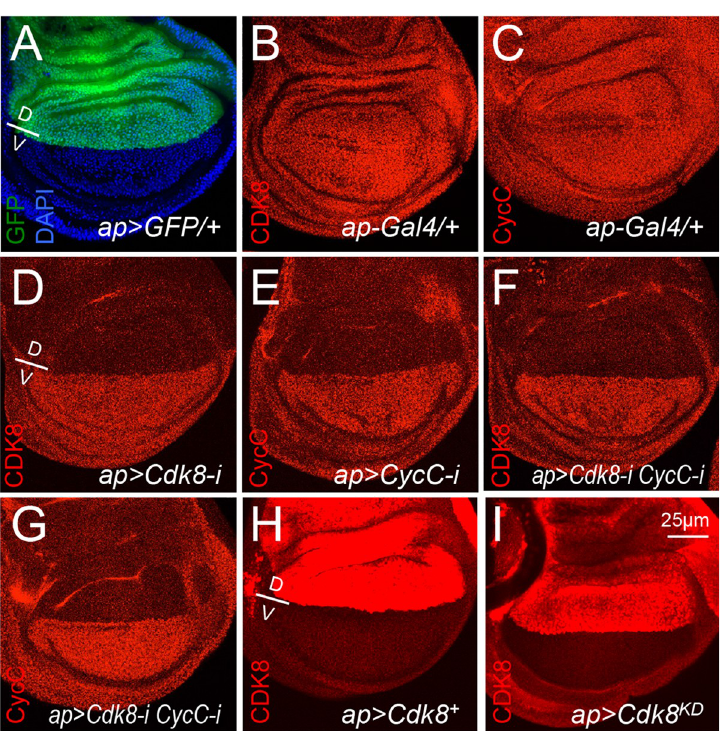
Fig 2. Validation of the specificity of the vein defects caused by depletion or overexpression of CDK8-CycC. Representative confocal images of the wing pouch area of a L3 wandering larval wing disc: (A) ap-Gal4/UAS-2XGFP with DAPI (blue) and GFP (green); (B) ap-Gal4/+ with anti-CDK8 (red) staining; (C) ap-Gal4/+ with anti-CycC (red) staining; (D) ap-Gal4/+; UAS-Cdk8-RNAi/+ with anti-CDK8 (red) staining; (E) ap-Gal4/+; UAS-CycC-RNAi/+ with anti-CycC (red) staining; (F) ap-Gal4/+; UAS-Cdk8-RNAi CycC-RNAi/+ with anti-CDK8 (red) staining; (G) ap-Gal4/ +; UAS-Cdk8-RNAi CycC-RNAi/+ with anti-CycC (red) staining; (H) ap-Gal4/UAS-Cdk8 + with anti-CDK8 (red) staining; and (I) ap-Gal4/UAS-Cdk8 KD with anti-CDK8 (red) staining. Note that the gain for confocal imaging in H and I is lower than the others to avoid over saturation of the signals. At least five wing discs were examined for each genotype. The dorsal/ventral (D/V) boundary is shown in A, D and H. Scale bar in I: 25 μ m.